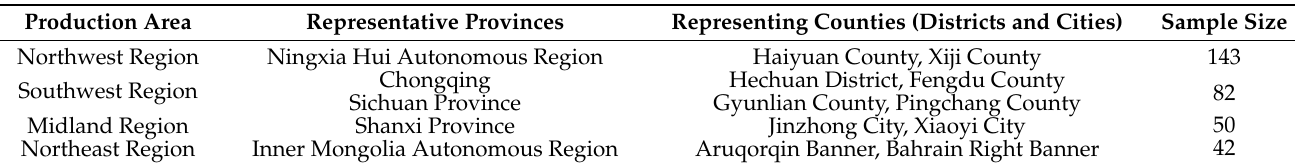
Table 1. Regional distribution of the research